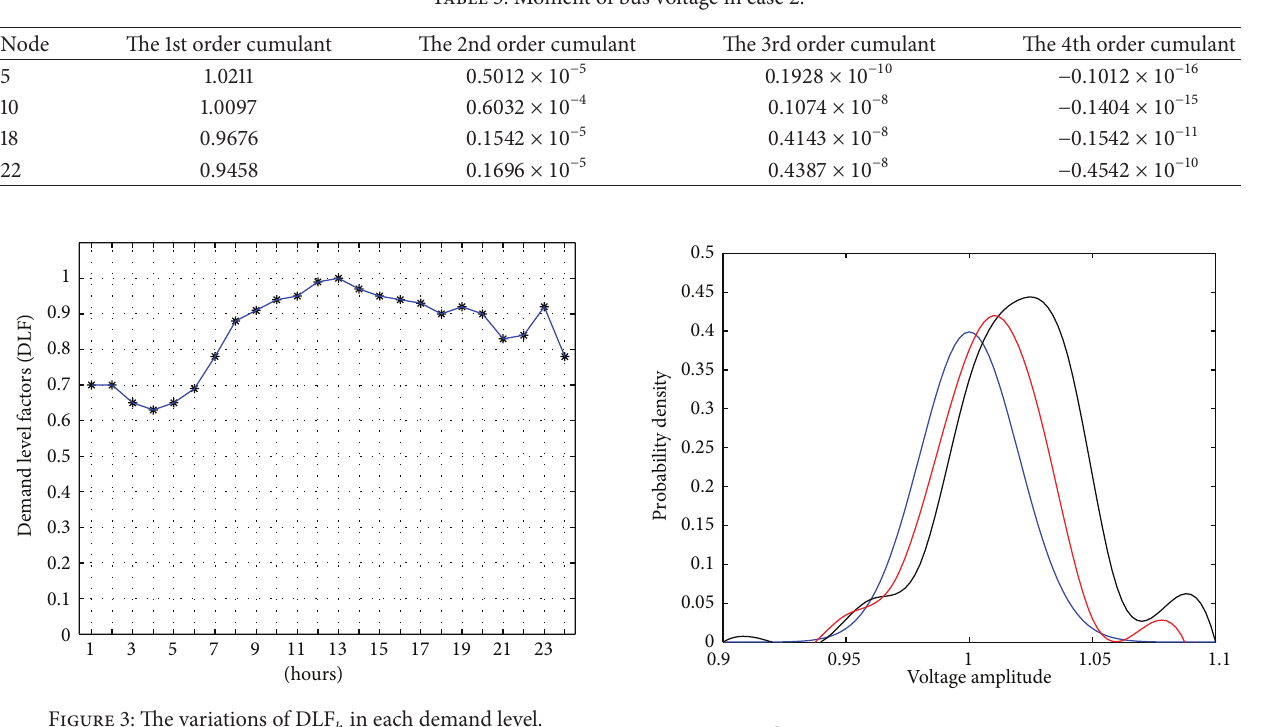
Table 3: Moment of bus voltage in case 2.